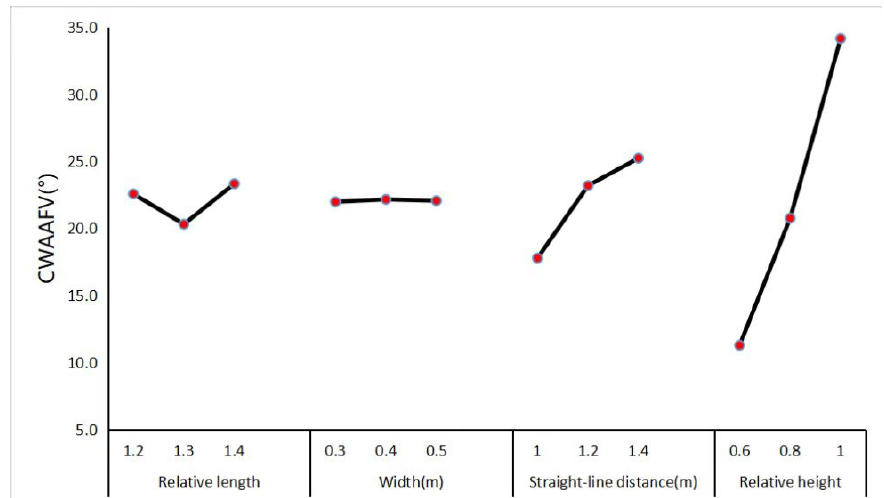
Figure 7. The trend of CWAAFV with three levels for each factor.